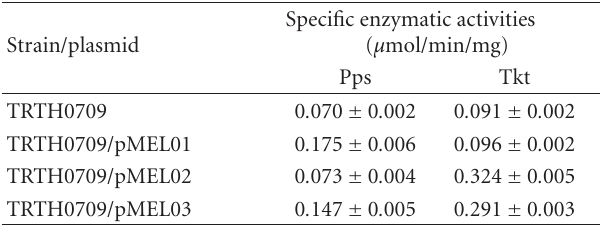
Table 2: Specific enzymatic activities of E. coli TRTH0709 harbor- ing di ff erent